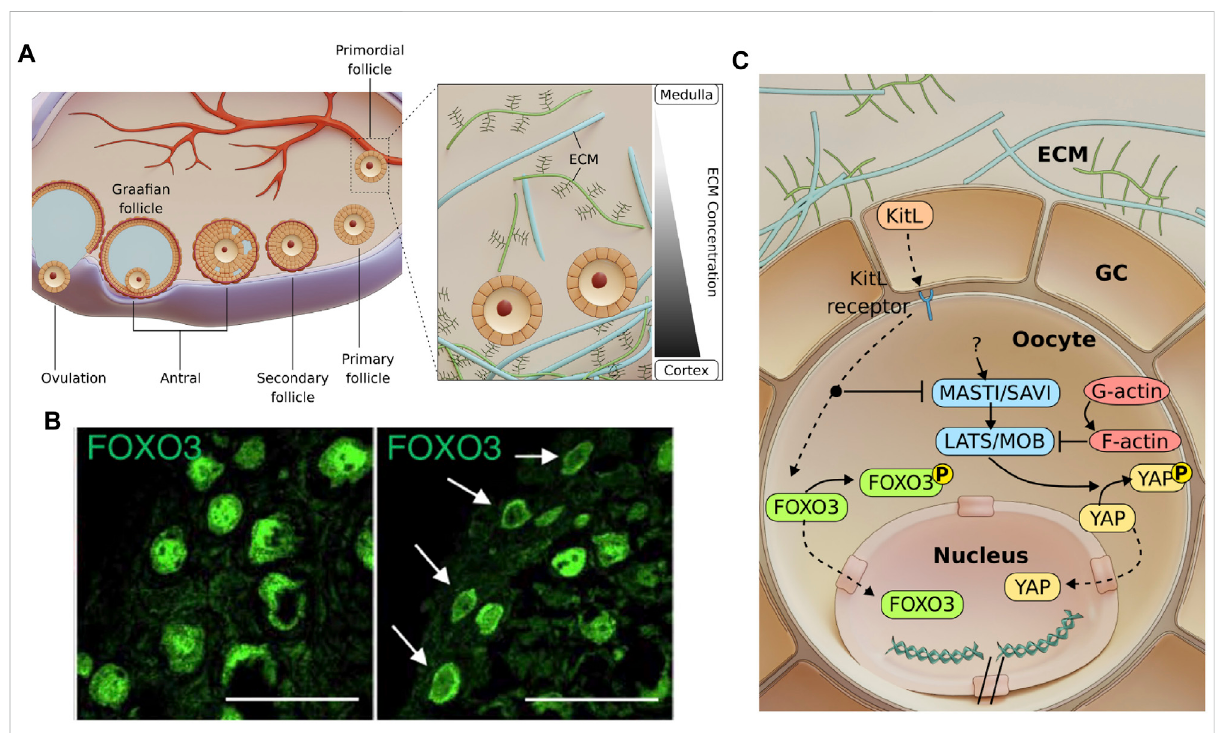
FIGURE 1 Follicle development and possible mechano-signalling pathways involved in primordial follicle activation. (A) . Mammalian folliculogenesis is classi fi ed into the primordial, primary, secondary and antral follicle stage. Antral follicles undergo ovulation to release the cumulus-oocyte complex before forming a corpus luteum. Inset: A gradient of ECM stiffness was proposed to extend from the soft ovarian medulla to the stiffer cortex where thedormantprimordialfolliclespredominantlyreside. (B) .Imagesshowingthatprimordialfolliclescanbeactivated via ECMdegradation(right), as indicated by FOXO3 cytoplasmic localisation compared to the nuclear localisation of FOXO3 in dormant primordial follicles (left). Scale bar: 50 μ m. Images from (Nagamatsu et al., 2019). (C) . Mechanosensitive Akt and Hippo pathways govern primordial follicle activation. GCs express Kit ligands (KitL), which are bound to the Kit receptors on the oocyte. Activating the Akt pathway leads to phosphorylation of FOXO3 in the cytoplasm. The Akt pathway also disrupts the Hippo pathway at MST1 to allow for YAP nuclear localisation and downstream activation and growth of follicle. Mechanical stress exerted by the GCs may independently activate mechanosensitive proteins and contribute to